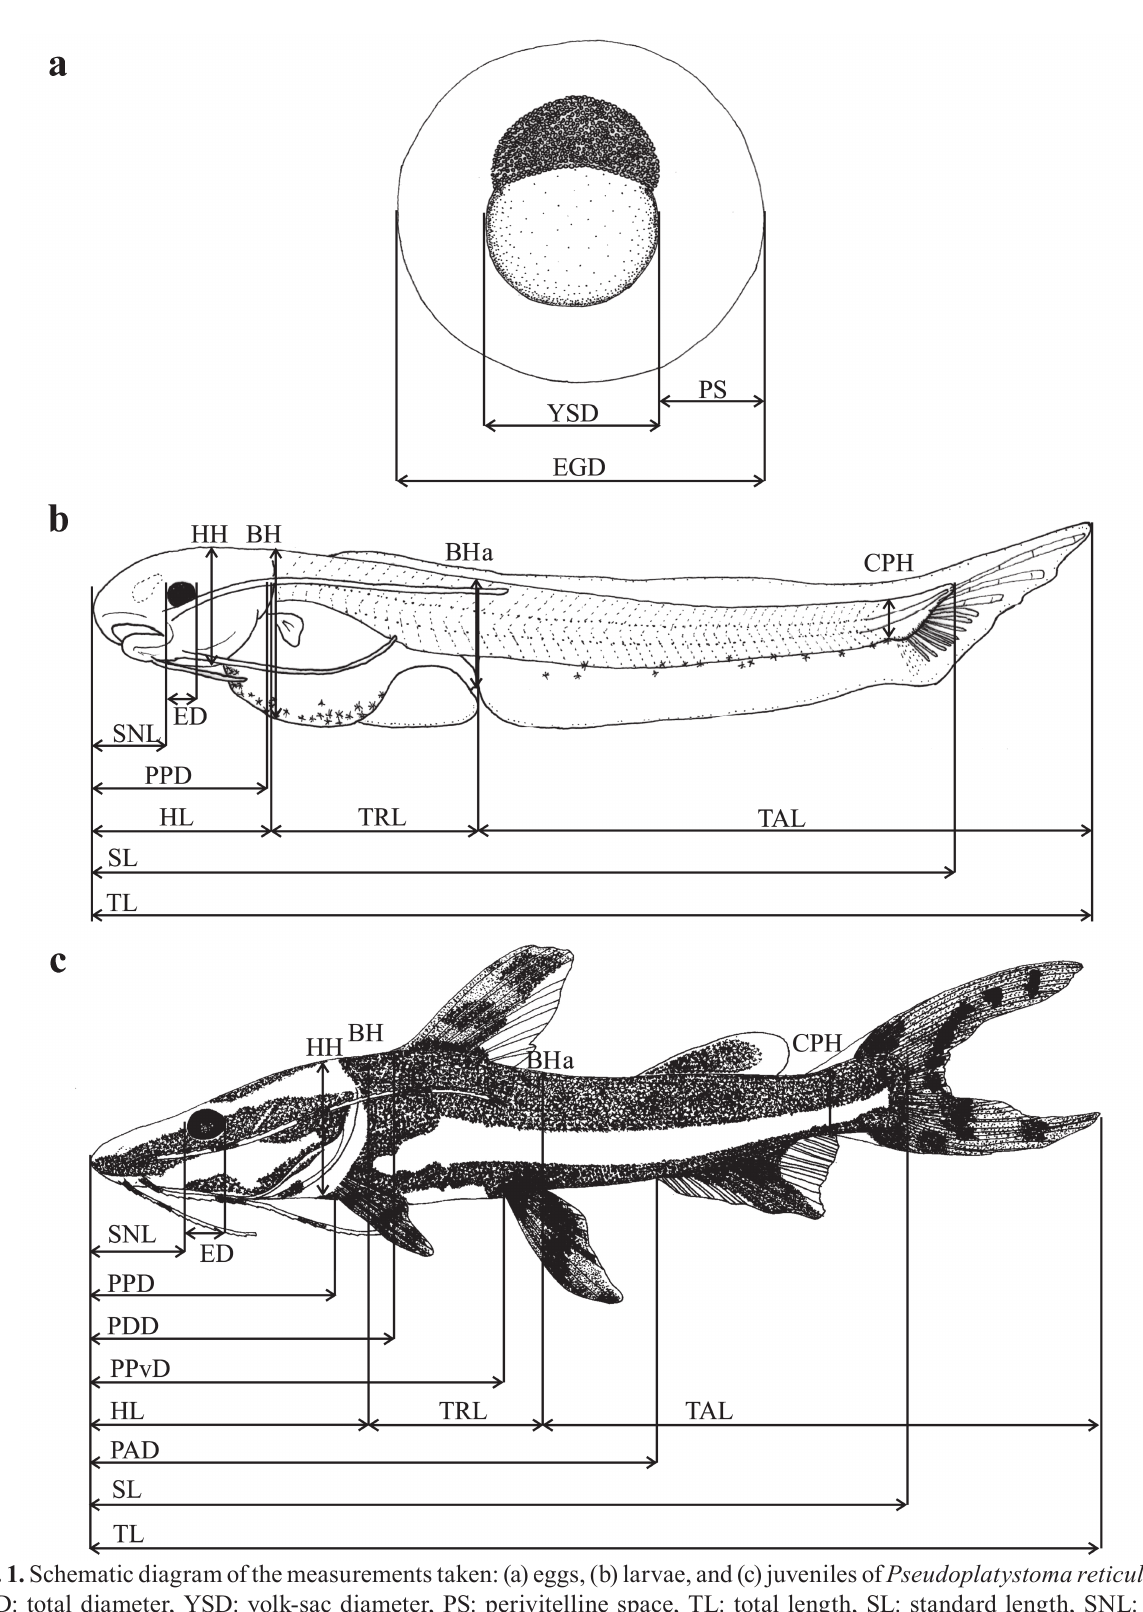
Fig. 1. Schematic diagram of the measurements taken: (a) eggs, (b) larvae, and (c) juveniles of Pseudoplatystoma reticulatum . EGD: total diameter, YSD: yolk-sac diameter, PS: perivitelline space, TL: total length, SL: standard length, SNL: snout length, ED: eye diameter, HL: head length, TRL: trunk length, TAL: tail length, HH: head height, BH: body height at the level of the pectoral fin, BHa: body height at the level of the anus, CPH: caudal peduncle height, PPD: pre pectoral-fin length, PPvD: pre pelvic-fin length, PDD: pre dorsal-fin length, and PAD: pre anal-fin